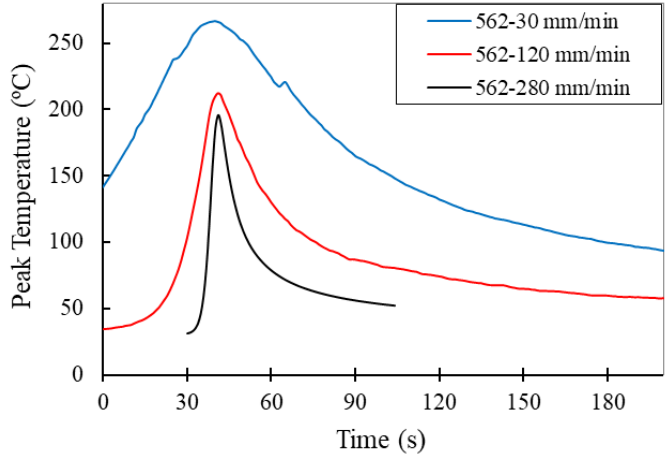
Figure 3. The thermal cycles measured in the 562 series, as performed using different welding speeds.